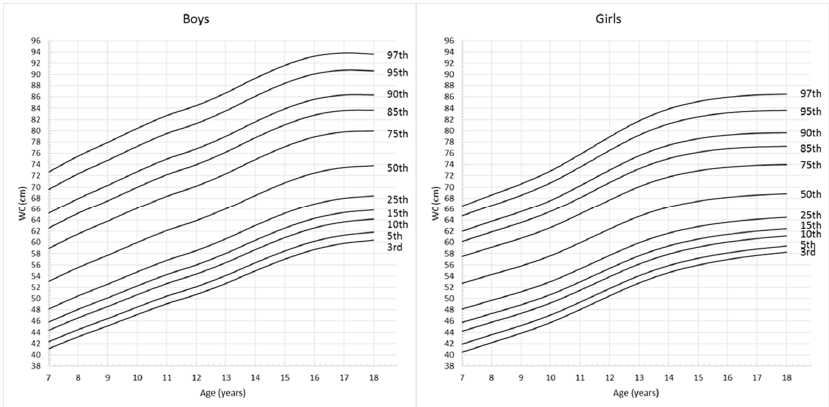
Figure 2. Gender- and age- specific WC percentile curves for Chinese children and adolescents aged 7–18 years.